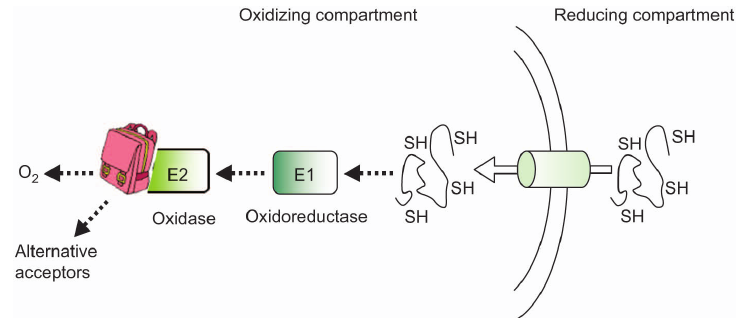
Figure 1 General scheme of the oxidative folding. Proteins are synthesized in a reducing compartment. Having been translocated to the compartment containing the machinery of oxidative folding, electrons from cysteinyl thiols are transferred to a final acceptor via an electron transfer chain composed by oxidoreductases. oxidants (4). Recently, two even more oxidizing DsbA hom- ologs were described from Neisseria meningitidis (-80 mV) (5, 6) and from Pseudomonas aeruginosa (-95 mV) (7) (for comparison, the standard redox potential of thioredoxin, a small oxidoreductase enzyme containing a dithiol-disulfide active site, is -270